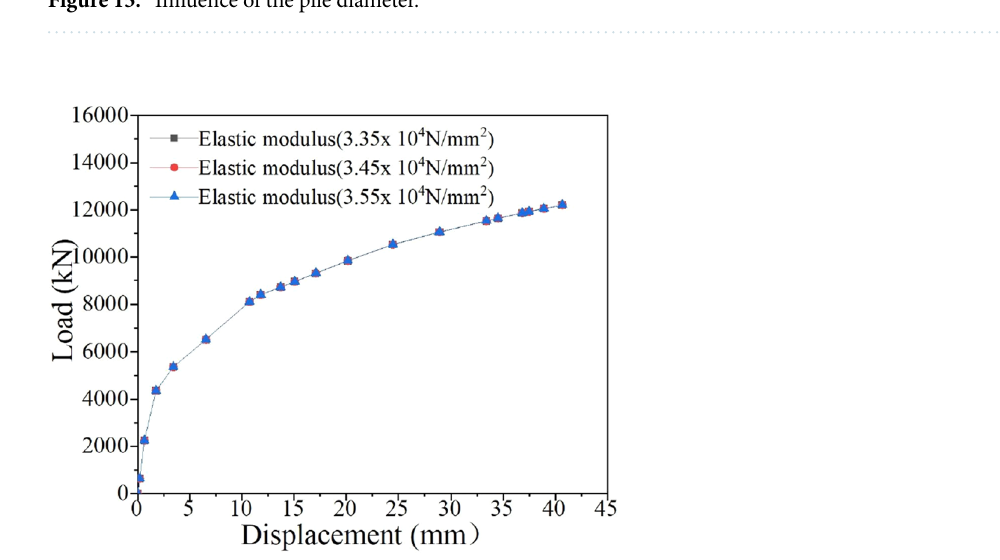
Figure 15. Influence of the pile diameter.